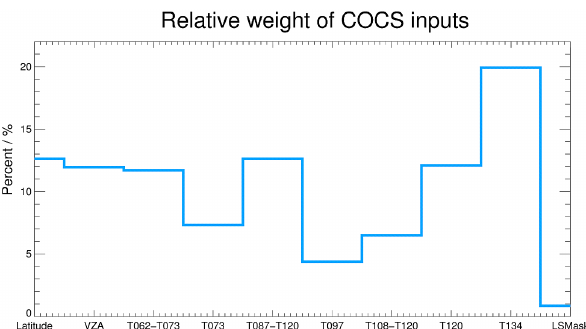
Figure 4. The relative weight of the single COCS inputs in percent, from right to left: latitude, viewing zenith angle (VZA), followed by the single BTs and BTDs, and the land–sea mask